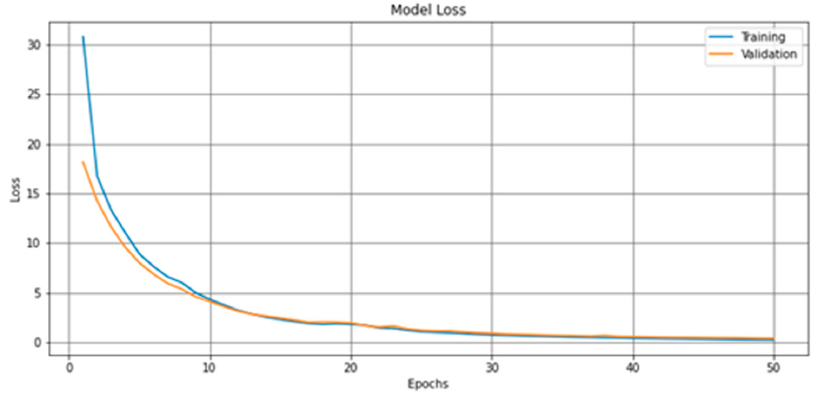
Figure 7. The loss graph produced from the deep-learning model described in Section 2.2.2 and